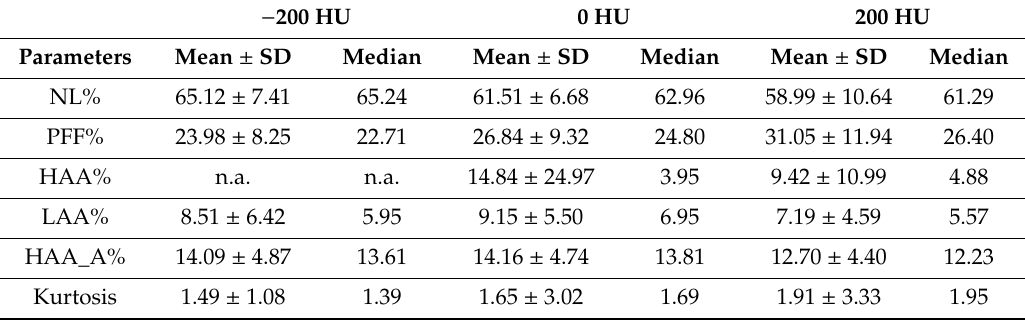
Figure 3. Pairwise scatter plot matrix, and correlation coe ffi cients ( ρ ) of HRCT histogram indices including kurtosis, mean lung density (MLD), variance, skewness, and median at -200 (left), 0 (right), and 200 HU (centre). Table 2. Mean (%) ± Standard Deviation (SD) and median values (%) of HRCT parameters obtained considering the three di ff erent HU thresholds. HAA, defined as the areas with attenuation values greater than − 200 HU, is not shown in the first